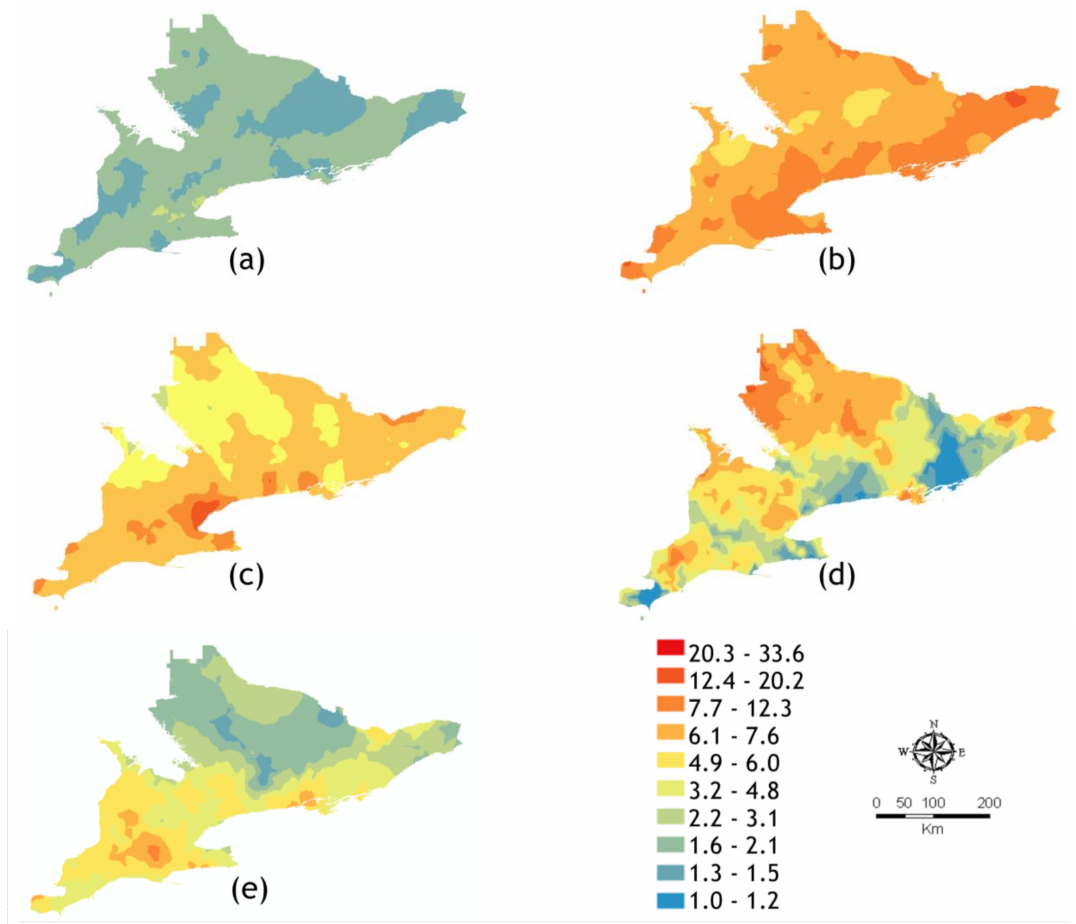
Figure 5. Predicted mean number of mosquitoes per trap-night data. ( a ) Ae. japonicus (simple kriging: MMTN, WET); ( b ) Ae. vexans (simple kriging: MMTN, POP); ( c ) Cx. pipiens / restuans (simple kriging: MMTN, WET); ( d ) Och. canadensis (universal kriging: MMTN, DEM); ( e ) Och. trivittatus (universal kriging: MMTN, POP). Abbreviations: DEM, digital elevation model; MMTN, mean number of mosquitos per trap-night; POP; proximity to population centres; WET, proximity to